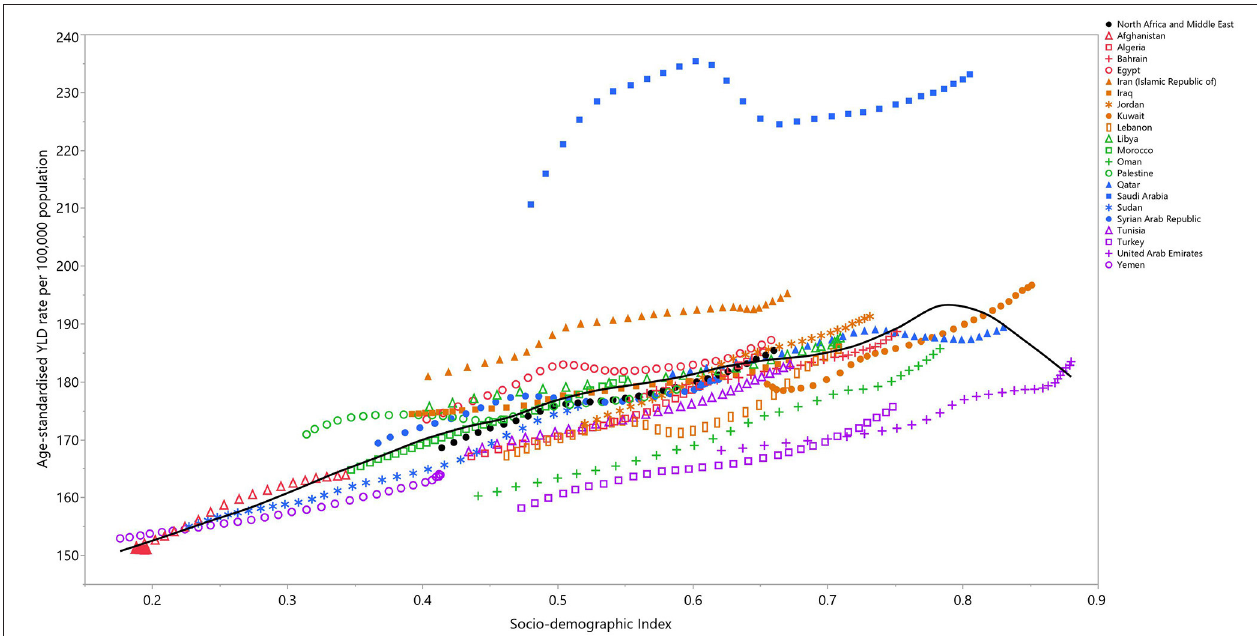
FIGURE 4 | Age-standardized YLD rates of osteoarthritis for 21 countries and territories, by SDI in 2019; Expected values based on the Socio-demographic Index and disease rates in all locations are shown as the black line. Each point shows the observed age-standardized YLD rate for each country in 2019. YLD, years lived with disability; SDI, Socio-demographic Index (generated from data available from